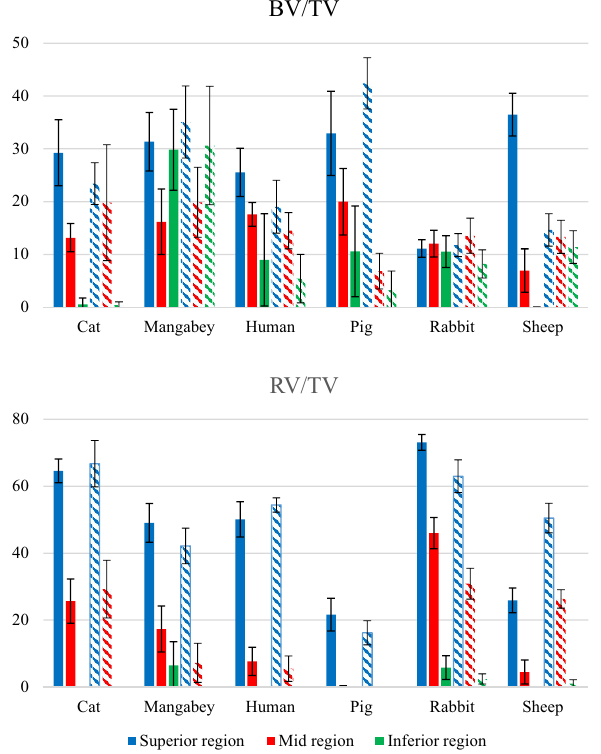
Figure 4. The BV/TV and RV/TV calculated within the superior, middle and inferior regions throughout the premolar (shown as solid bars) and molar (shown as hatched bars) regions. The error bars indicate ± 1 standard deviation of the mean